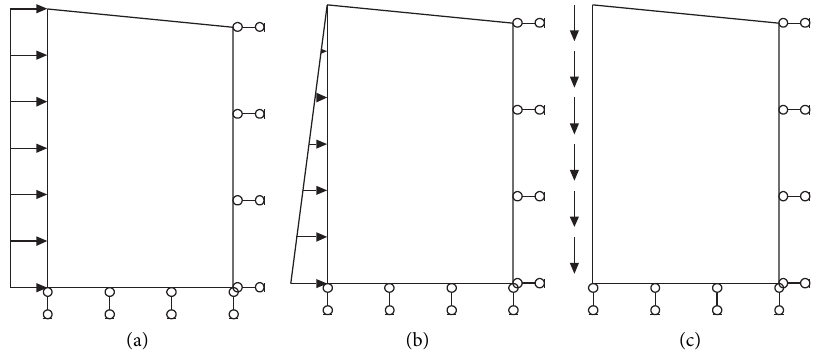
Figure 1: The assumed distribution of boundary load, which contributes to the tectonic stress